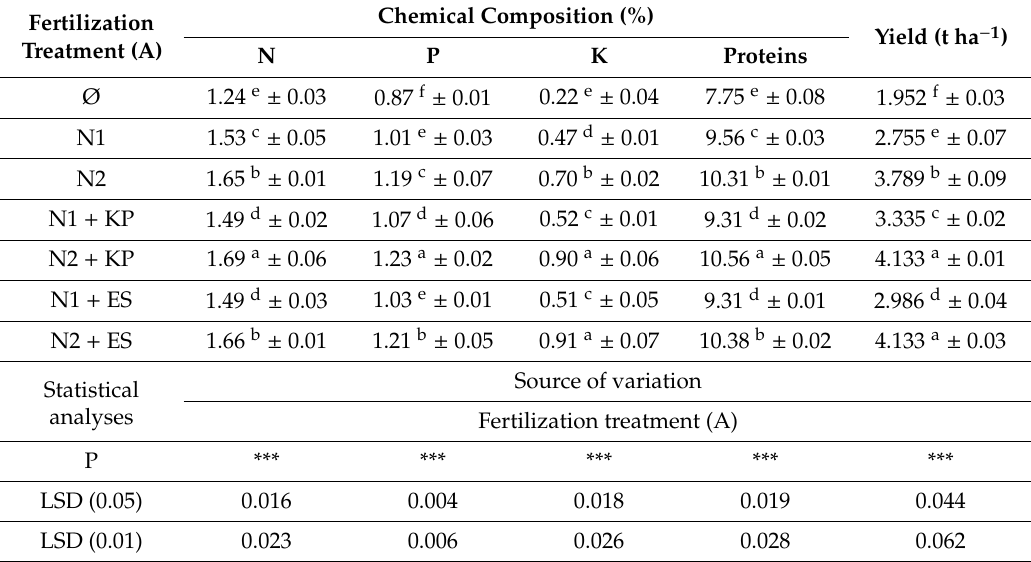
Table 9. E ff ect of the fertilization treatments on yield and average chemical composition of the maize grain (means ± standard